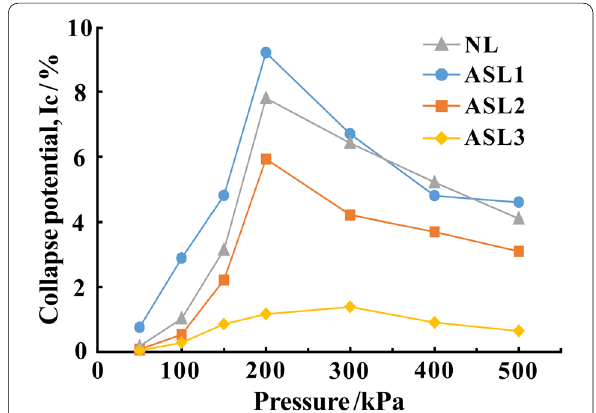
Fig. 6 Variation of the collapse potential with pressure